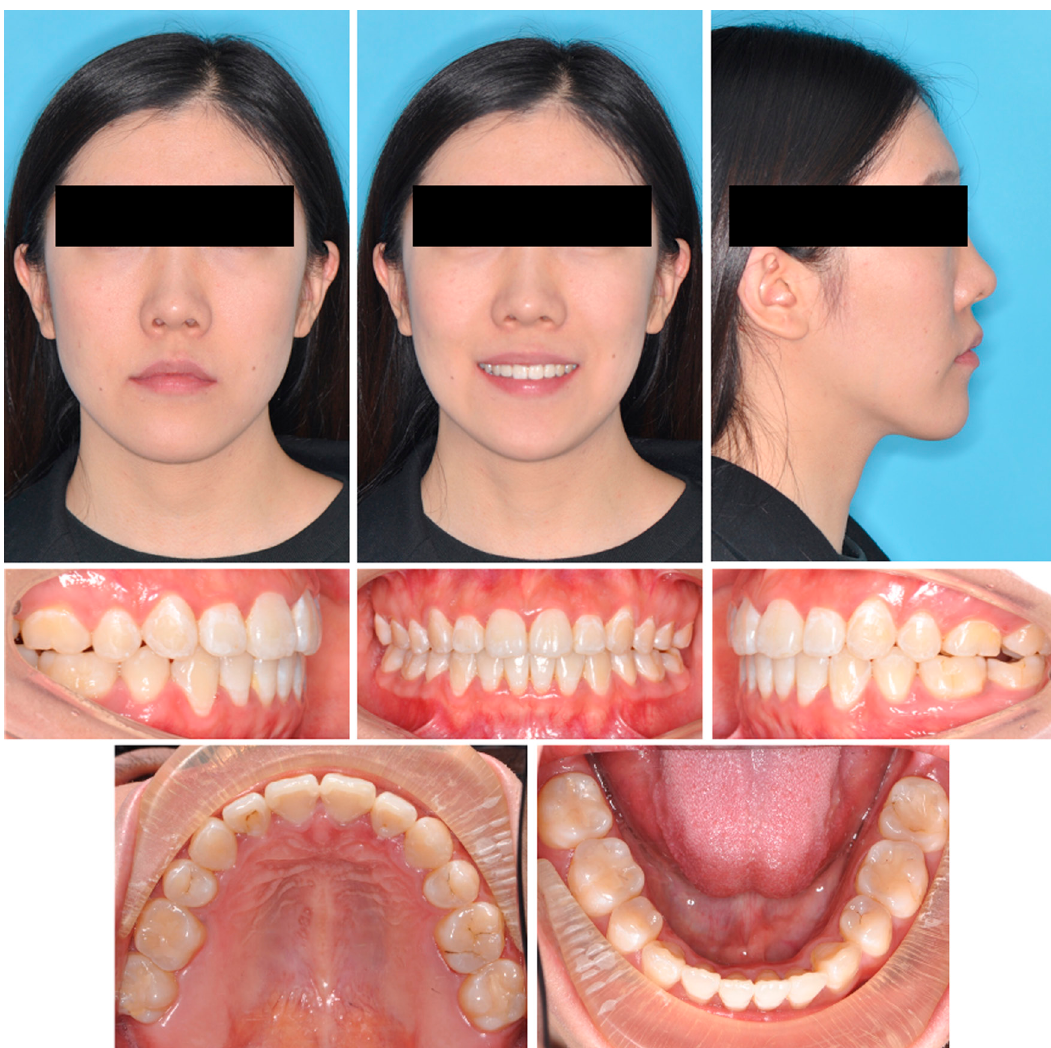
Figure 7. Post-treatment extraoral and intraoral